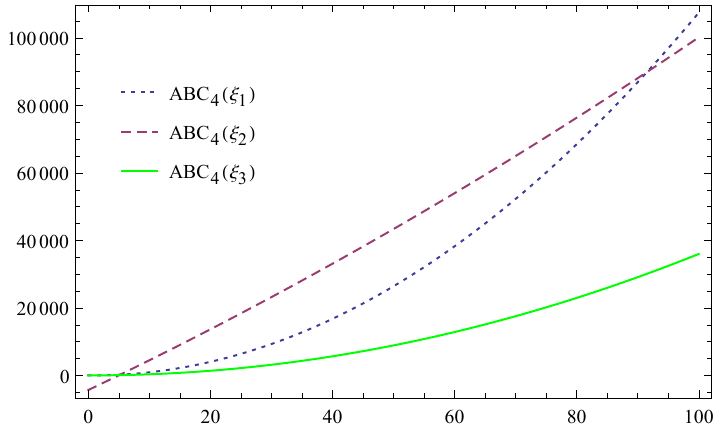
Figure 5. Comparison of ABC 4 index for ξ 1 , ξ 2 and ξ 3 .